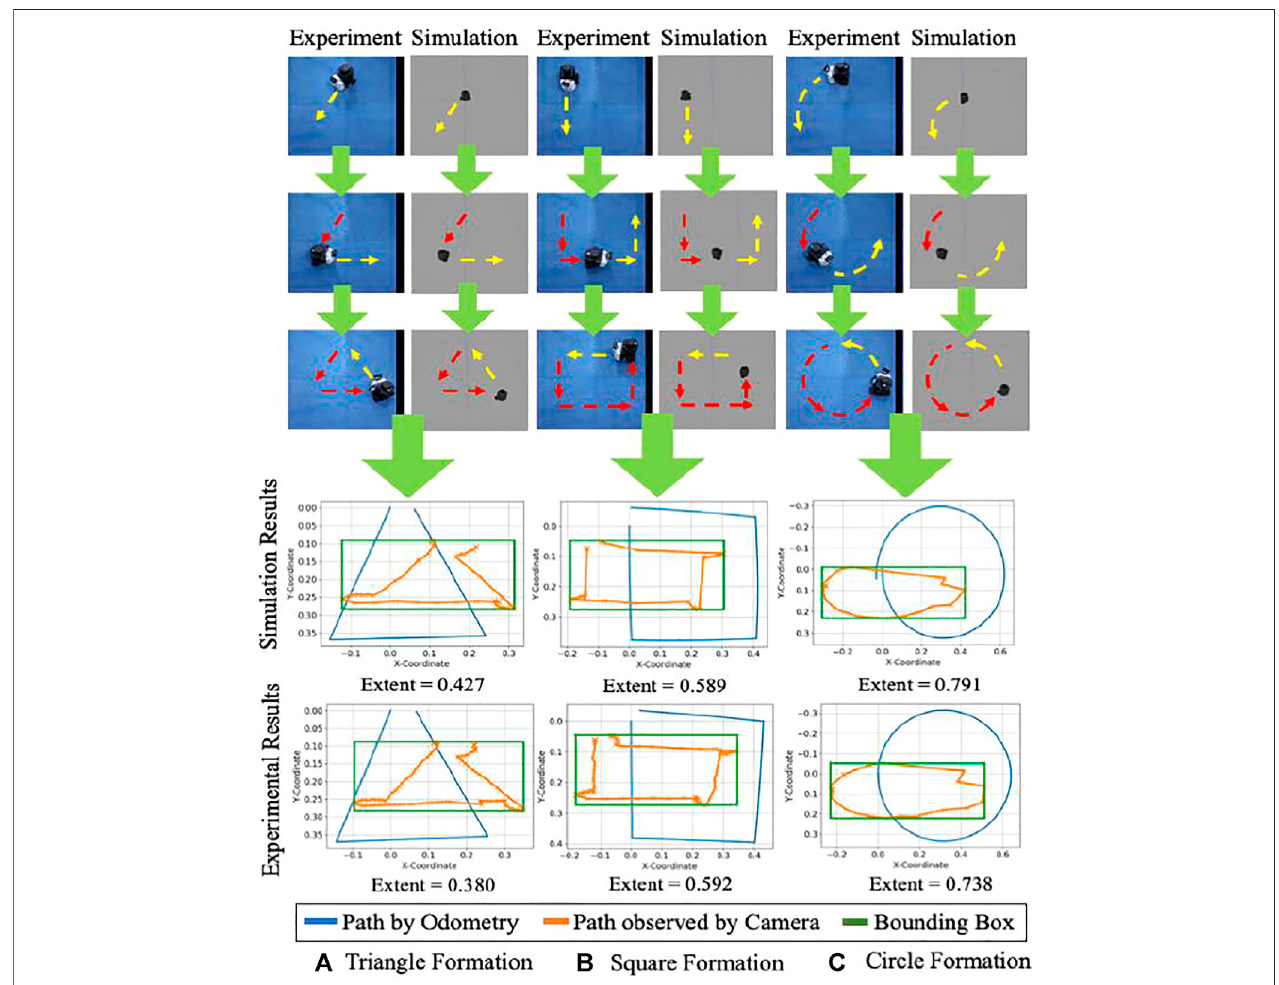
FIGURE 8 | Frame-by-frame shape formation in experiment and simulation. Red arrows indicate the path which has been traced, and yellow arrows indicate the prospective path to be followed. A comparison of odometry data with the path captured by the camera is shown for the physical system and simulation. The bounding box is represented for the observed shape, and the extent of the area is